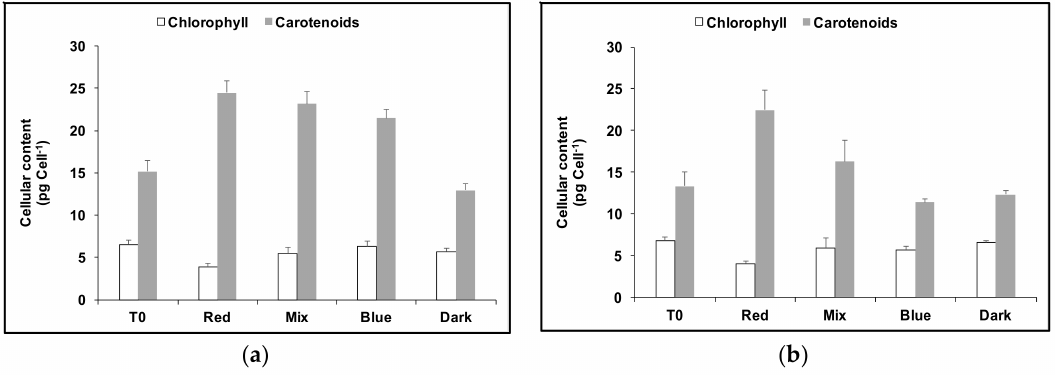
Figure 6. Cellular content of total carotenoids and chlorophyll under continuous blue ( a ) or red ( b ) LED light at 1000 µ mol m − 2 s − 1 for 24 h followed by 24 h growth under either red light, a mix of 1:1 red and blue light, blue light at the same light intensity of 1000 µ mol m − 2 s − 1 or dark. Each culture condition was set up at least in triplicate. T0: time point after growth for 24h only, in either blue (a) or red (b) light at 1000 µ mol m − 2 s − 1